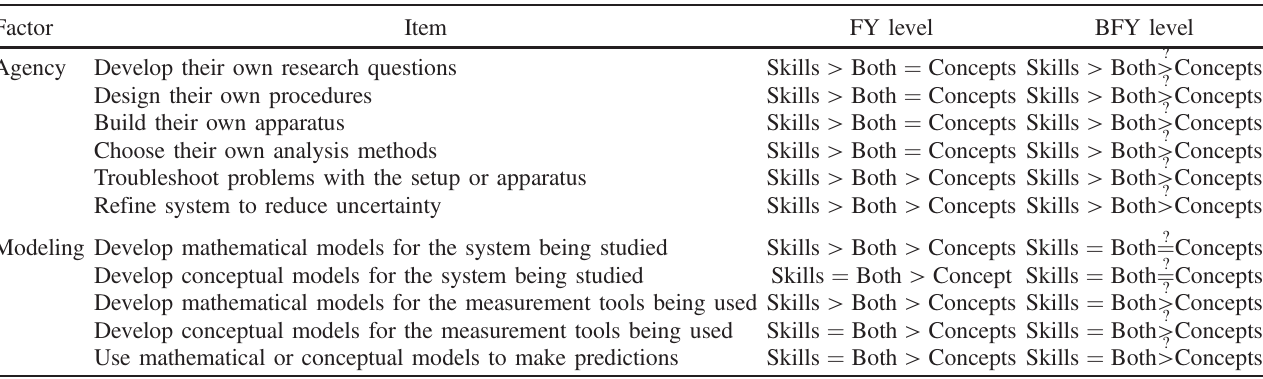
TABLE III. Post hoc pairwise comparisons between course levels and purposes on each of the items on the agency and modeling factors. Note that the small number of BFY-level courses exclusively aiming to reinforce concepts make these comparisons unreliable [indicated with the question marks above the (in)equalities].